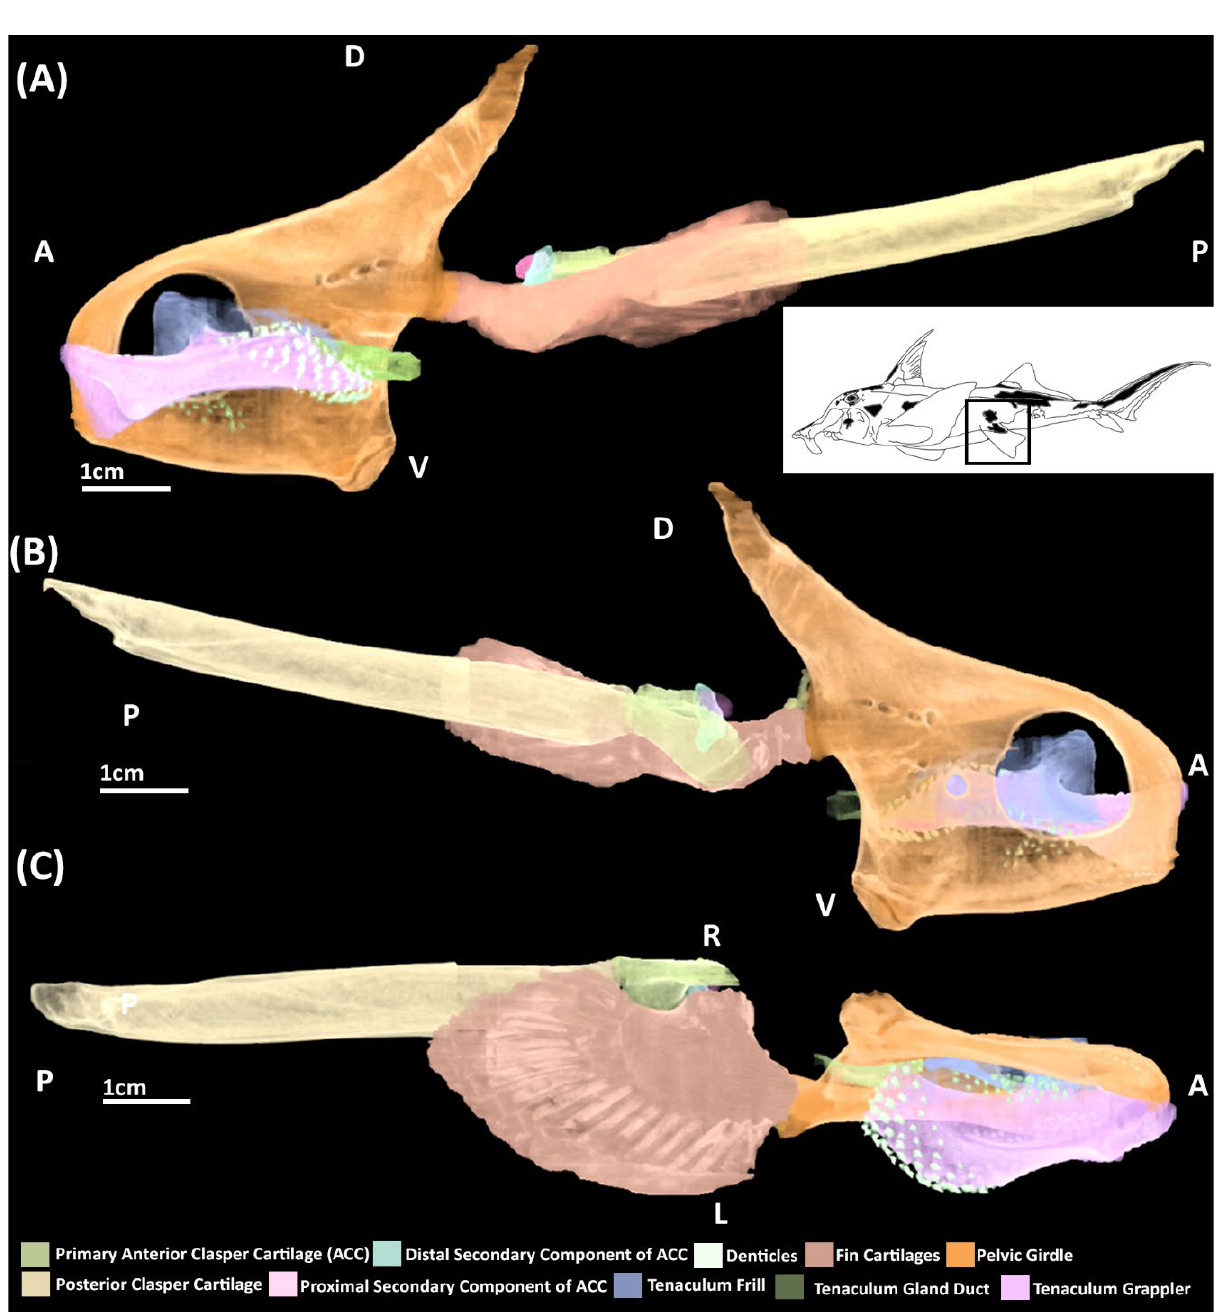
Figure 2. MicroCT models of the pelvic skeleton of an adult male elephant shark ( Callorhinchus milii ). ( A ) Models viewed from a distal lateral view; ( B ) models viewed from a proximal lateral view; ( C ) models viewed from a ventral view.